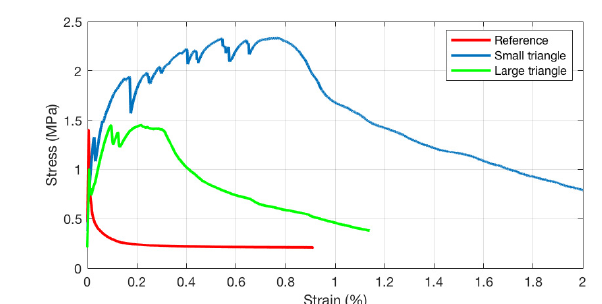
Figure 9. Stress ‐ strain curves for specimens tested in uniaxial tension after 7 days.